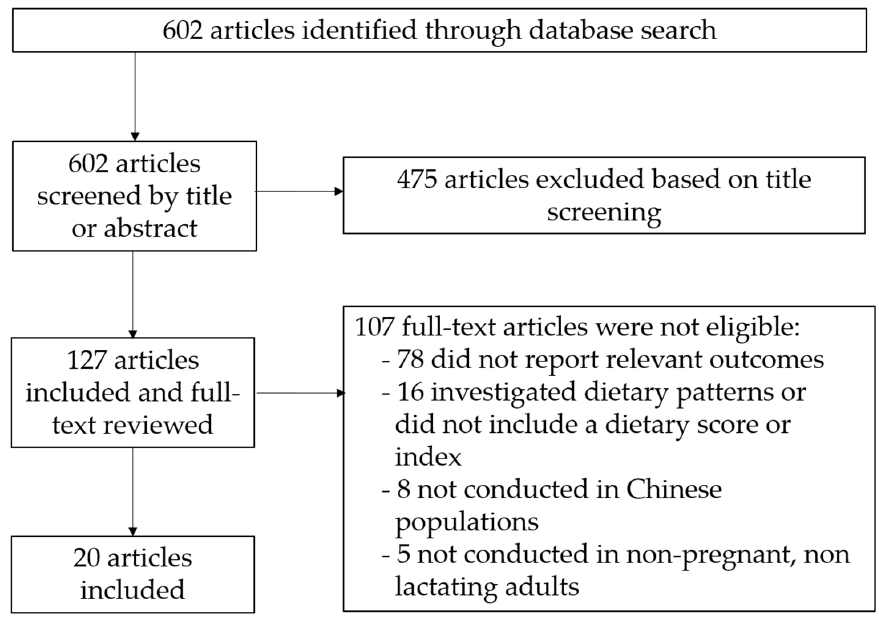
Figure 1. Flowchart selection.